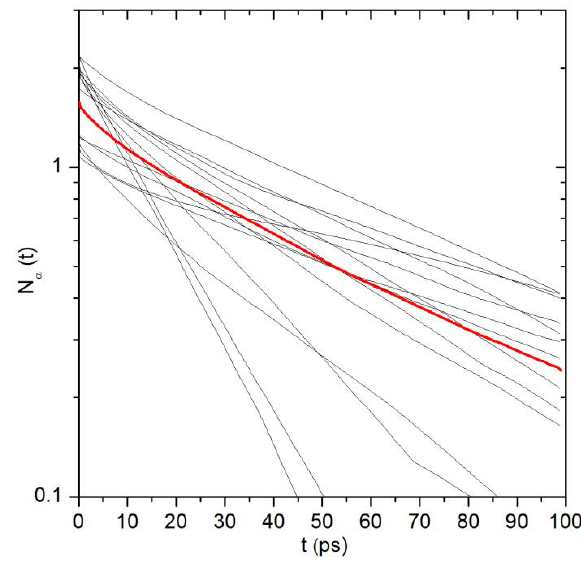
Figure 7. Water survival time correlation functions calculated separately for the Asn676-OD1 group of four protein subunits and four MD trajectories (black curves). Red curve is the average of the black